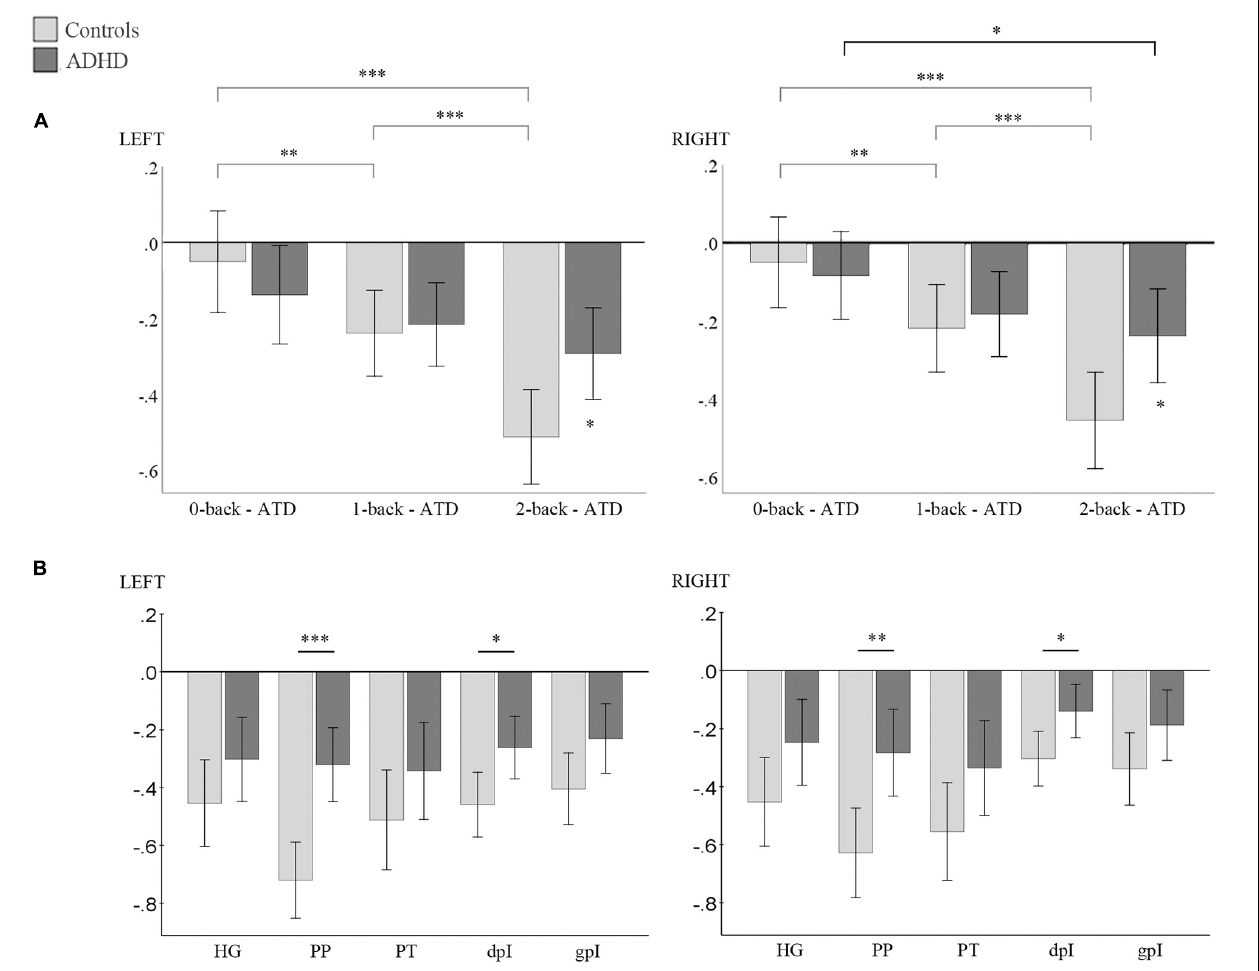
FIGURE 4 | (A) Results of post hoc analysis for the WM load × Group interaction. Within group differences indicated by horizontal lines above graph. Between group differences indicated by asterisk above error bars. (B) Results of post hoc analysis for the ROI × Group × High load interaction. Between-group differences indicated by horizontal lines above graph. Left panel: left hemisphere; right panel: right hemisphere. Bonferroni correct p -values: ∗ p < 0.05, ∗∗ p < 0.01, ∗∗∗ p < 0.001; error bars = 95% CI. ATD = auditory target detection. y -axis = estimated marginal means. HG, Heschl’s gyrus; PP, planum polare, PT, planum temporale, dpI, dysgranular posterior insula; gpI, granular posterior